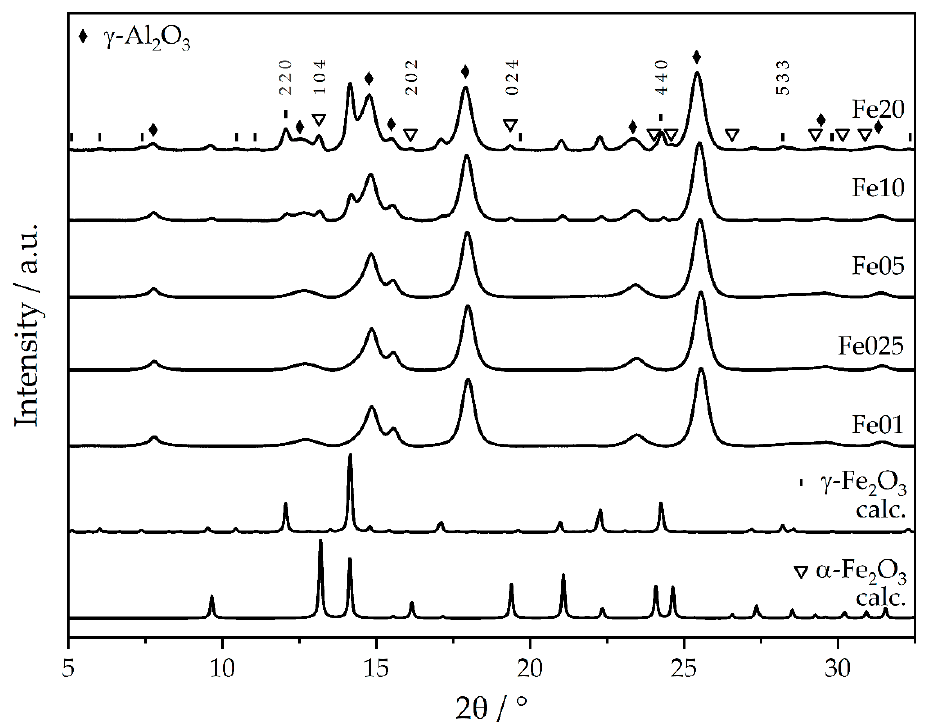
Figure 1. Experimental high-resolution powder X-ray diffractograms of catalysts Fe01 to Fe20 and calculated diffractograms of γ -Fe 2 O 3 and α -Fe 2 O 3 , respectively, maghemite and hematite (beamline P24, DESY).